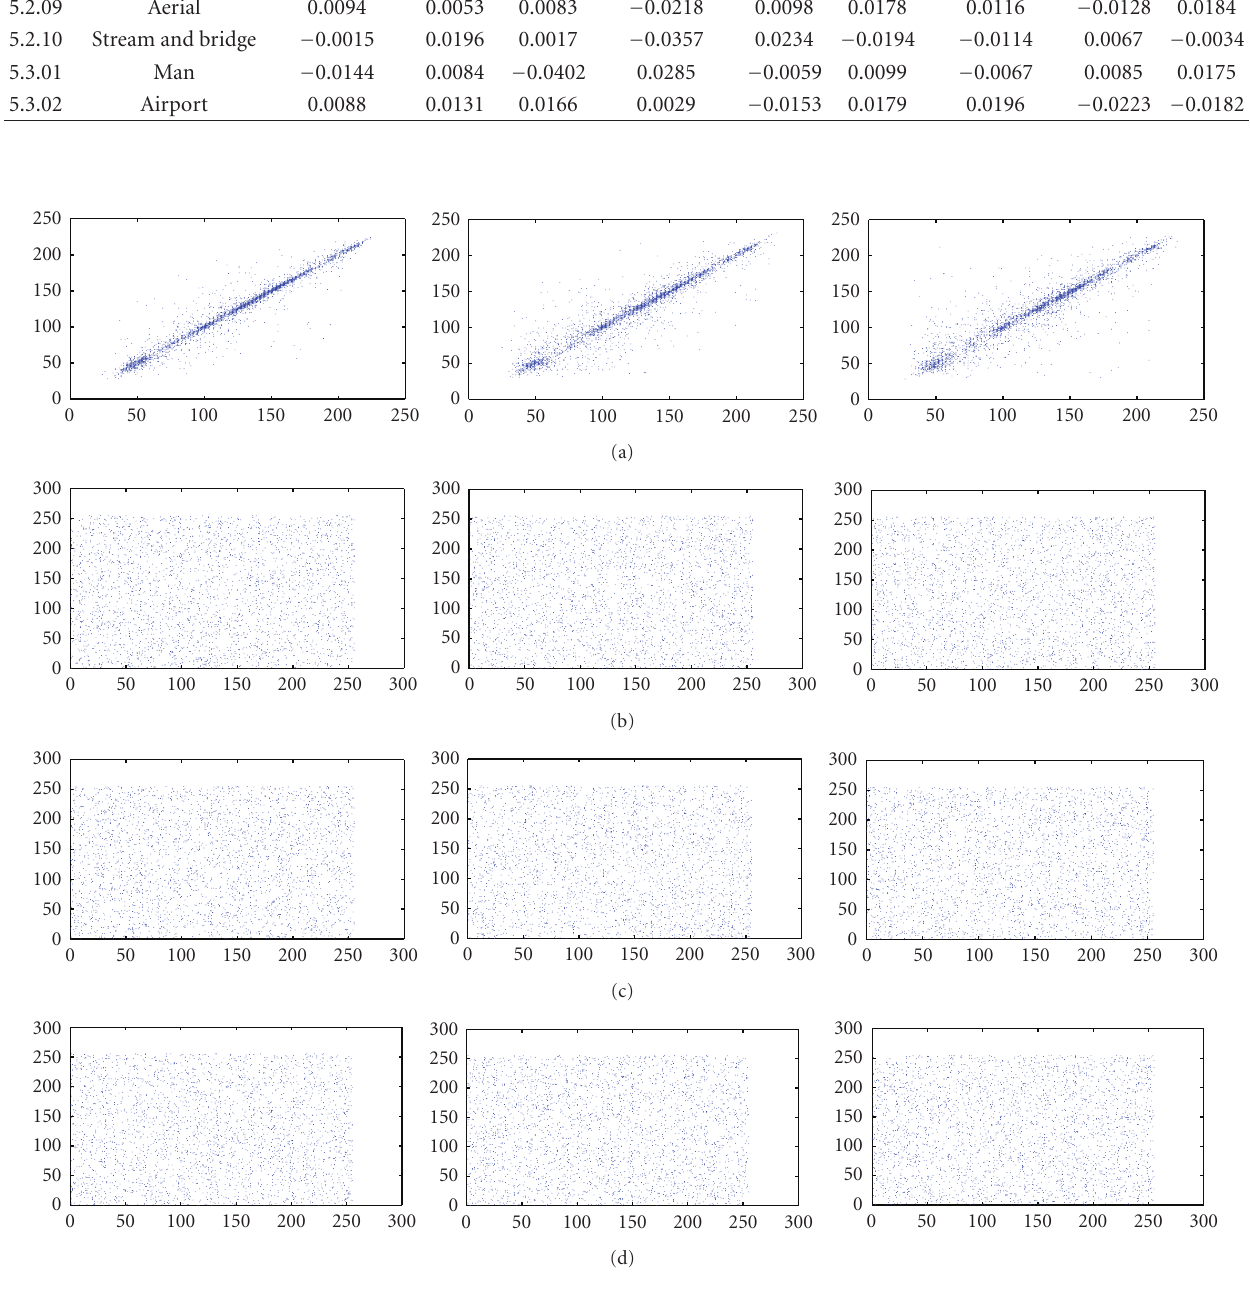
Figure 3: Correlation chart. left side with neighborhood of horizontal, center with neighborhood of vertical, right side with neighborhood of diagonal (a) Lena Standard image (b) the described algorithm (c) A5/1 algorithm and (d) W7